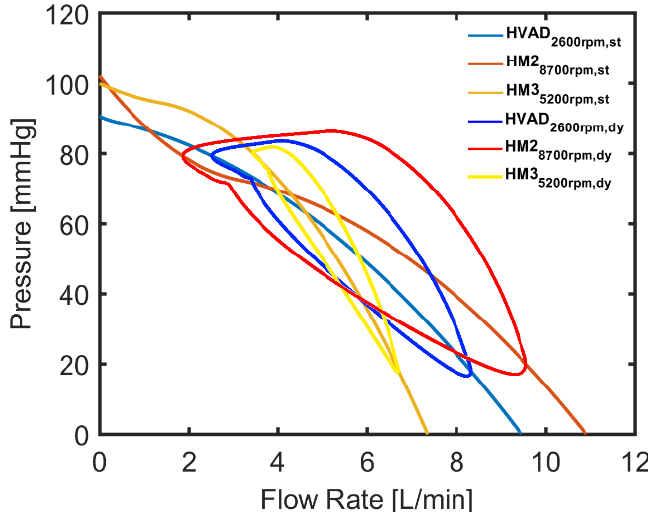
Figure 6. Static (st) and dynamic (dy) pressure head and flow rate relations of HVAD, HM2 and HM3 devices at 2600 rpm, 8700 rpm and 5200 rpm operating speeds, respectively.